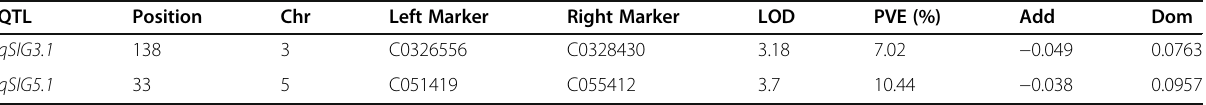
Table 2 Details of QTLs mapped in the F 2 population